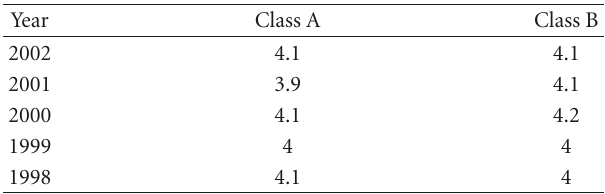
Table 2: Digital Signal Processing teaching feedback survey; the average marks for the first section.